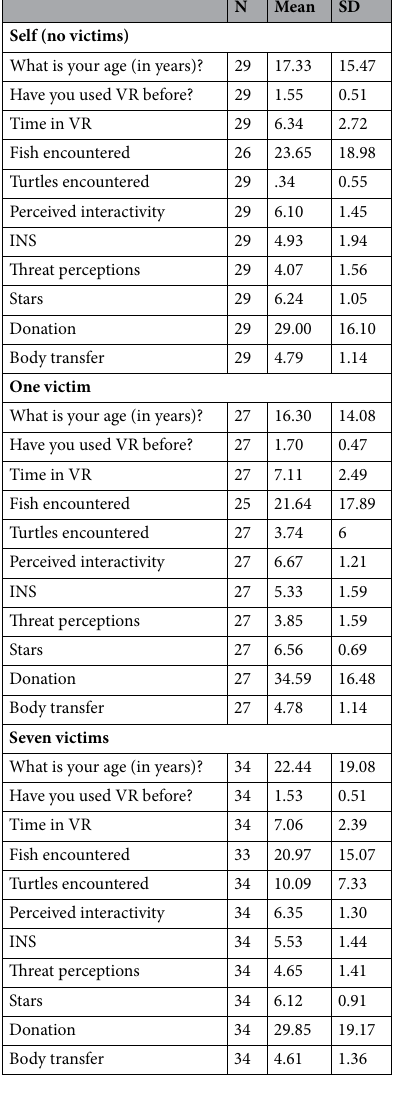
Table 3. Mean scores across experimental conditions in Study